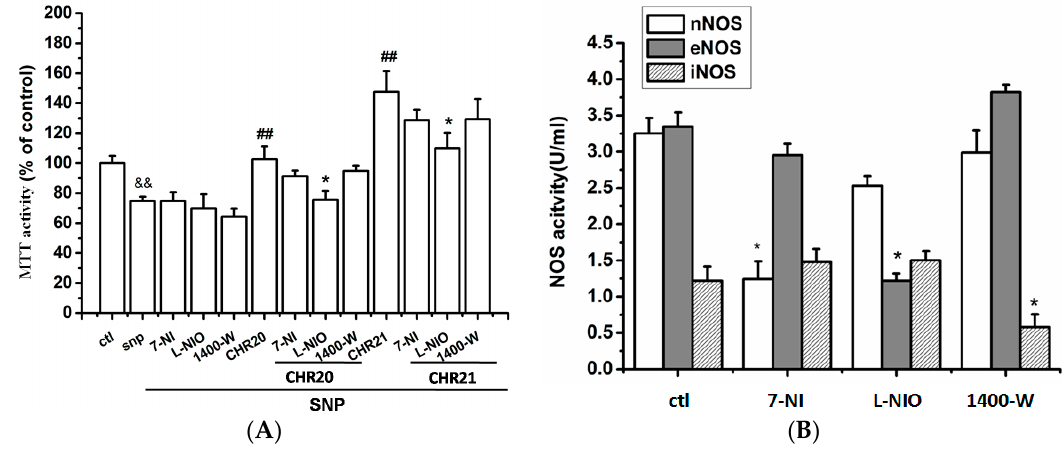
Figure 7. Effects of NOS on the action of CHR21 . ( A ) Endothelial nitrioxide synthase (eNOS) mediates the action of CHR21 on MTT activity in RGC-5 cells. Cells pre-exposed to 7-nitroindazole (7-NI, 50 μ M, 30 min), an specific inhibitor for neuronal nitric oxide synthase (nNOS), N (5)-(-iminoethyl)- L -ornithine ( L -NIO, 100 μ M, 30 min), an inhibitor of endothelial NOS (eNOS), and compound 1400-W (20 μ M, 30 min), a potent inhibitor of inducible NOS (iNOS), respectively, were treated with CHR20/CHR21 . The MTT activity of cells determined by MTT assay. Only L -NIO attenuated the protective effects of CHR20/21 on RGC-5 cells with statistically significant; while 7-NIO and 1400 W had no statistically significant effect. && p < 0.01 vs. control; ## p < 0.01 vs. SNP group; * p < 0.05 vs. CHR20 + SNP or CHR21 + SNP ( n = 3); ( B ) Effects of 7-NI, L -NIO and 1400 W on the NOS activities in RGC-5 cells. RGC-5 cells were treated with 7-NI, L -NIO and 1400 W, respectively. By applying Typed NOS Detection Kit, determination of the activities of nNOS, eNOS (endothelial NOS) and iNOS was carried out. One nmol of NO formed per mL cell lysate in one minute was defined as U/mL. With * p < 0.05 vs. control group, the difference is considered statistically significant. All values are expressed as mean ± SD ( n = 3).